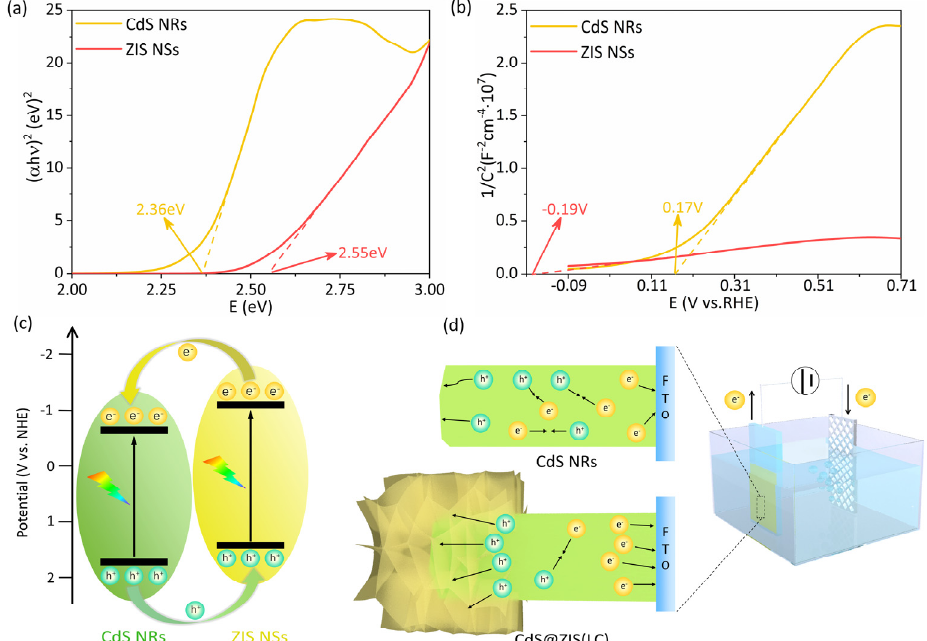
Figure 6. ( a ) Tauc plots and ( b ) Mott—Schottky plots of CdS NRs and ZIS NSs. ( c ) Band structure of CdS@ZIS and possible carriers transfer pathways ( d ) Charge transfer mechanisms of photoanode.